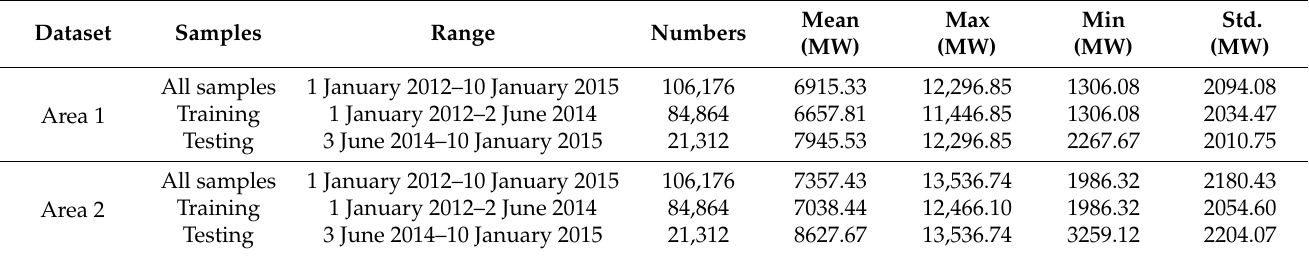
Figure 9. Load trend chart for four consecutive weeks for Area 1. Table 1. Dataset load details.